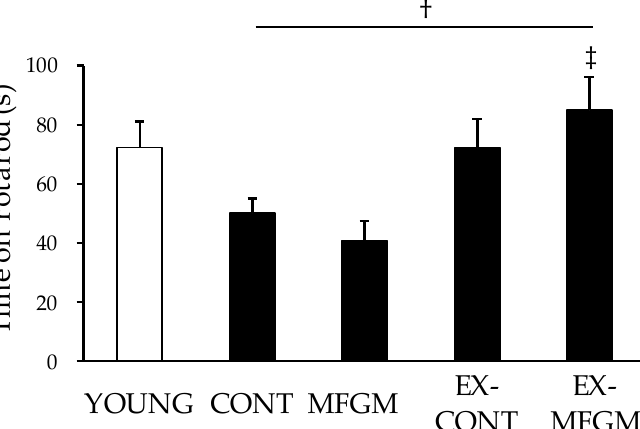
Figure 2. The effect of MFGM with exercise on motor function. The rotarod test was performed in 17-month-old BALB/c mice. Mice were placed on the rotarod accelerating from 4 rpm to 40 rpm. Values are means ± SE ( n = 8–12 in each group). † p < 0.05 vs. CONT group, ‡ p < 0.05 vs. MFGM diet group by Tukey’s test. MFGM, milk fat globule membrane. YOUNG, young group; CONT, control diet group; MFGM, milk fat globule membrane diet group; EX-CONT, control diet with exercise group; EX-MFGM, milk fat globule membrane diet with exercise group.